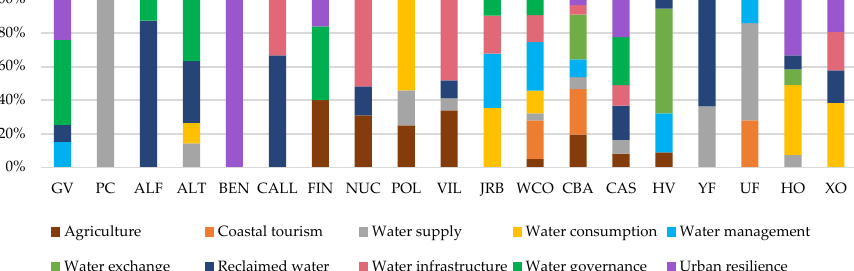
Figure 4. Codes coverage by stakeholder. Note: government officials (GV: regional government—